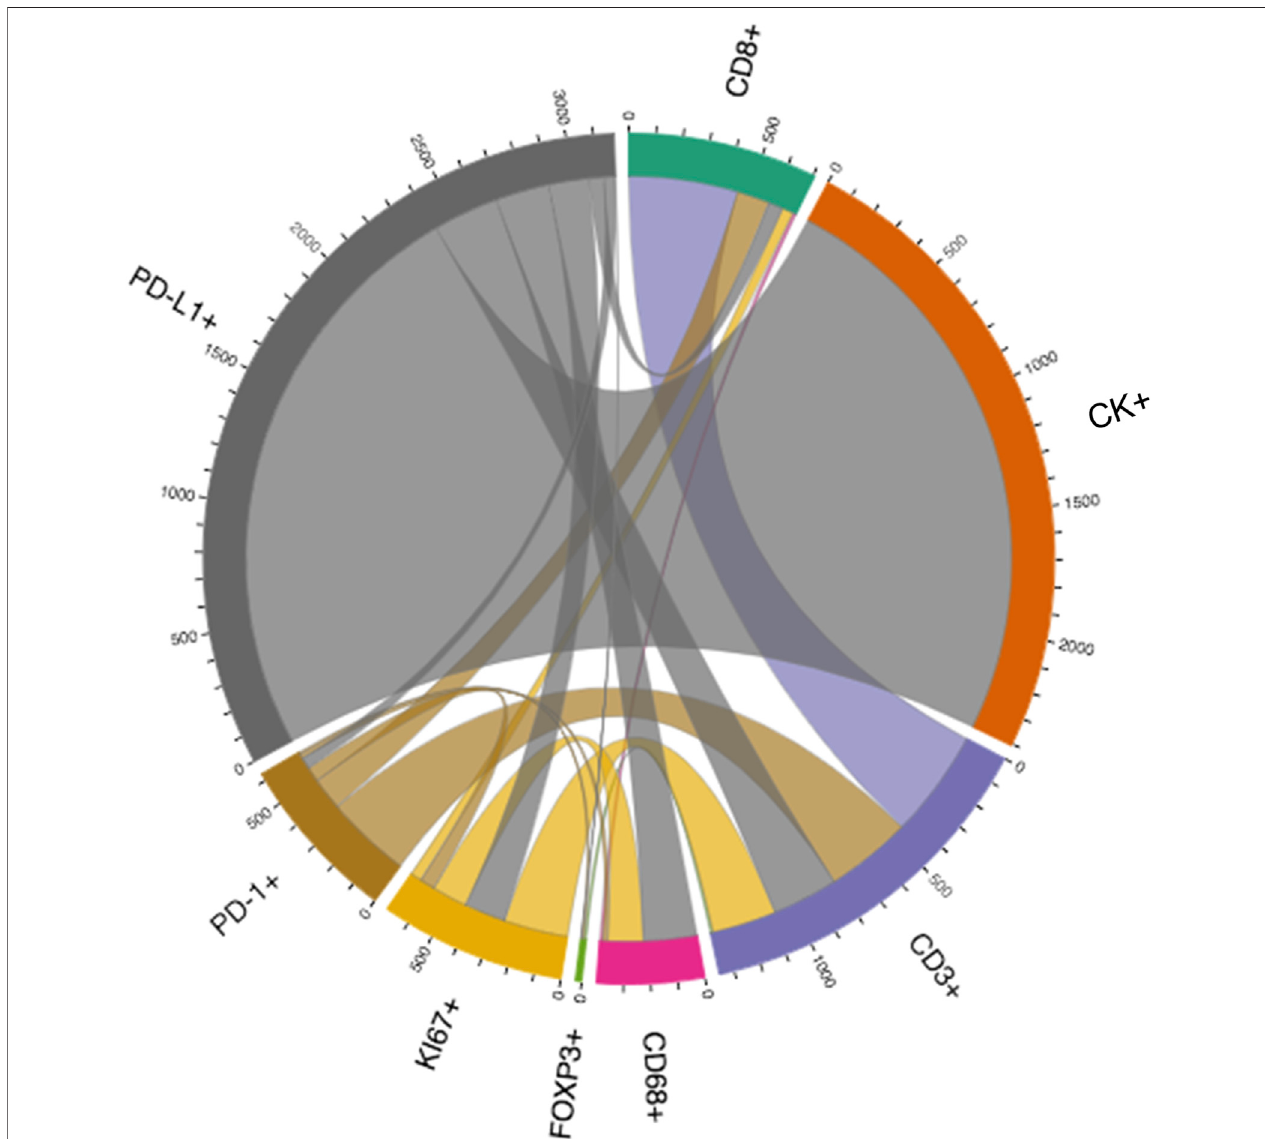
FIGURE 6 | Graphic representation of a distance matrix using a chord diagram showing the fl ows or connections between the markers included in a multiplex immuno fl uorescencepanel.Thechorddiagramshowsvariousconnectionsbetweenmarkersthatgeneratecellphenotypesfromamultipleximmuno fl uorescencepanel; these markers include cytokeratin (CK), CD3, CD8, FOXP3, PD-1, PD-L1, KI67, and CD68. The graphic was generated using R studio software version